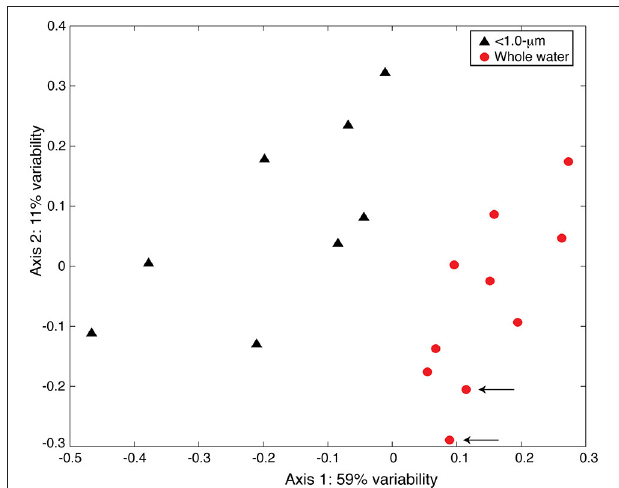
FIGURE 6 | NMS ordination of 16S rDNA TRFLP samples ( Hin 6I). The < 1.0- µ m (black triangles) and the whole water (red circles) incubations are presented. The stress for this ordination is 0.124 and the r 2 between the original distance matrix and this NMS ordination is 0.90. The degree of variability represented by each axis was calculated using a Mantel test (see text) and is shown in the axis label. Arrows indicate samples from the original